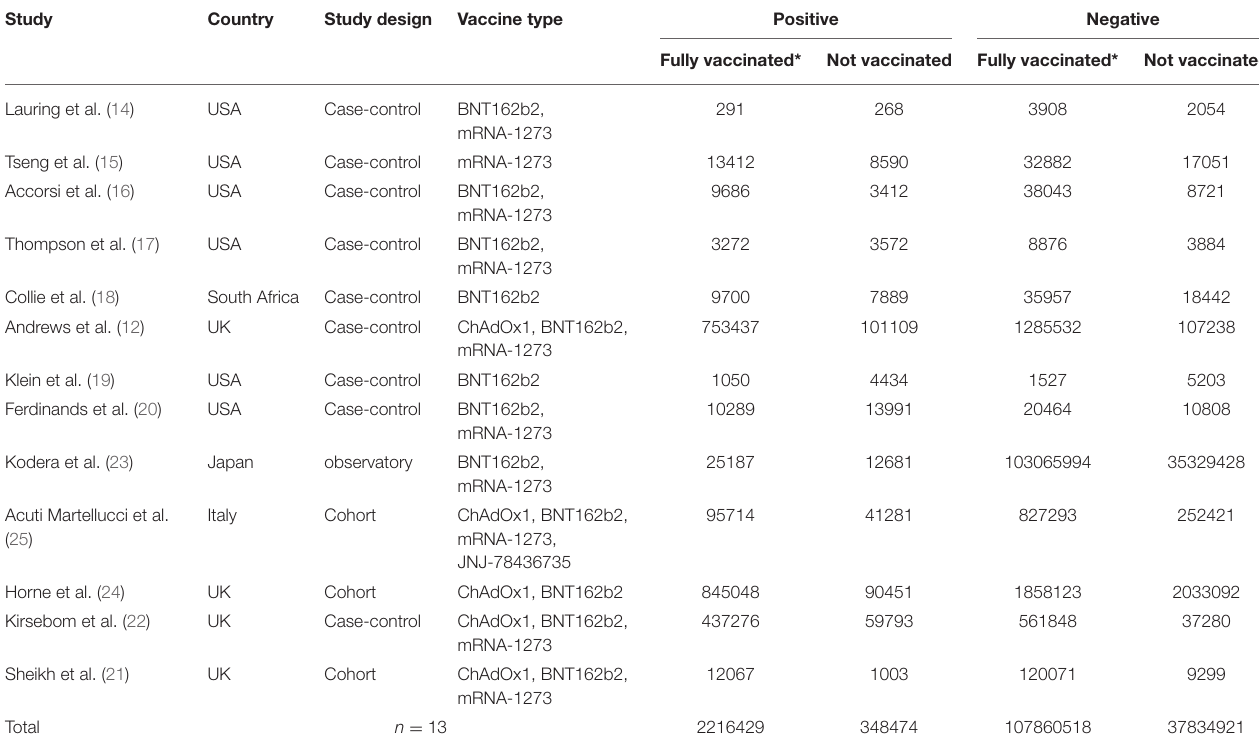
TABLE 1 | Characteristics of the selected